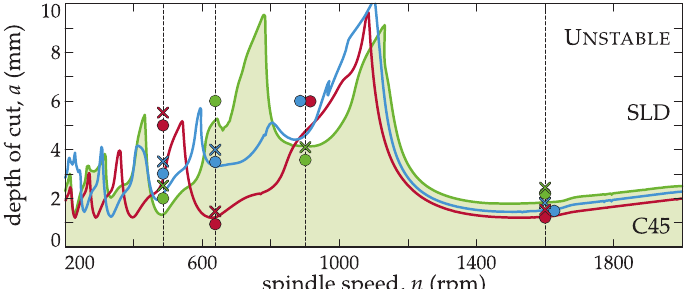
Figure 7. SLD’s of different tuning methodologies for C45 steel workpiece (green: BF, red: regular, blue: BS; circle: stable, cross: unstable